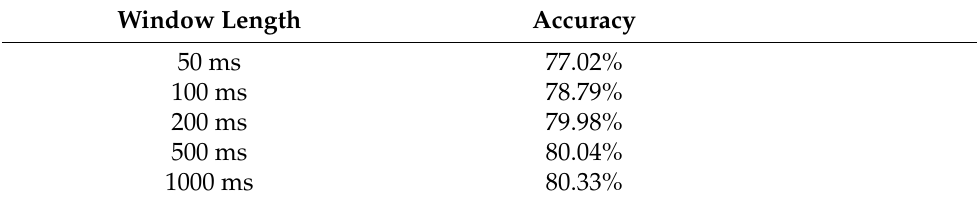
Table 2. Window Length Analysis. Both training and test data used the whole grasp period. The classifier used was lightGBM. The features used were STD, RMS, IEMG, MAV, WL, SSI, AAC, and DASDV mentioned in Figure 1. The cross-validation method used was leave-one-repetition-out cross-validation which used one repetition data for testing and the rest three repetitions for training the model, and repeated this process four times to cover all repetitions for